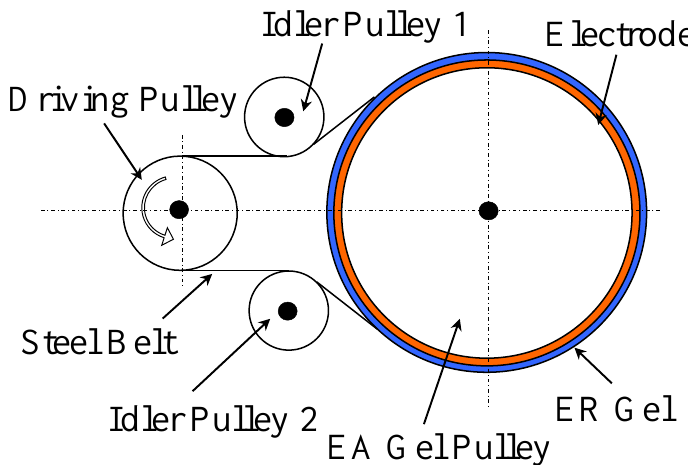
Figure 15. Schematic of the apparatus in Figure 14. The transmitted torque T was measured with a load cell pushed by an arm fixed to the driven shaft. The relation between the transmitted torque and the shear stress is